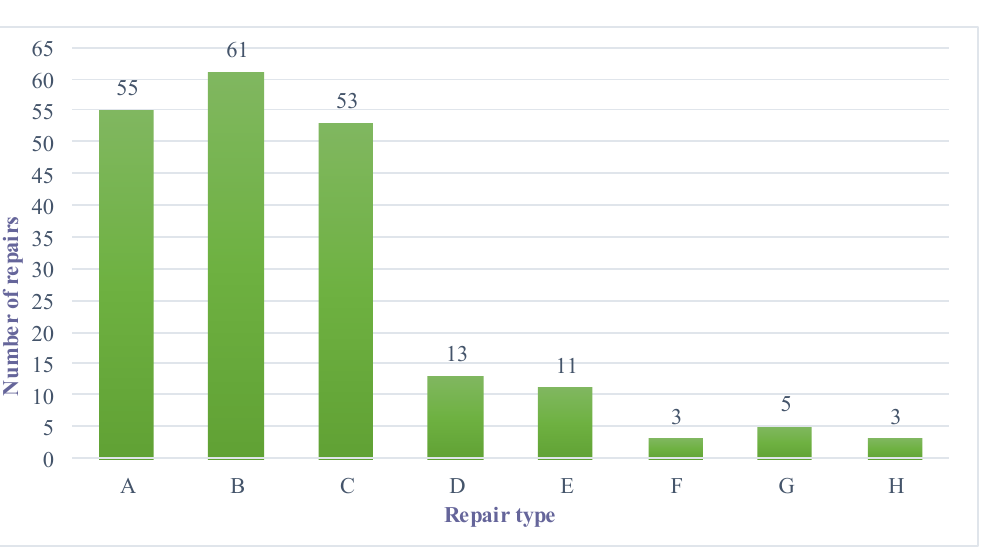
Figure 8. Total number of the A-H elements repairs.